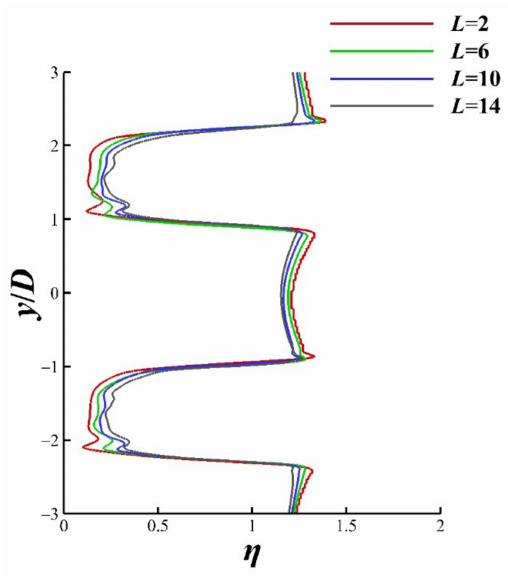
Figure 15. Flow velocity contours of turbine array under four different loads: ( a ) L = 2, ( b ) L = 6, ( c ) L = 10, and ( d ) L = 14.